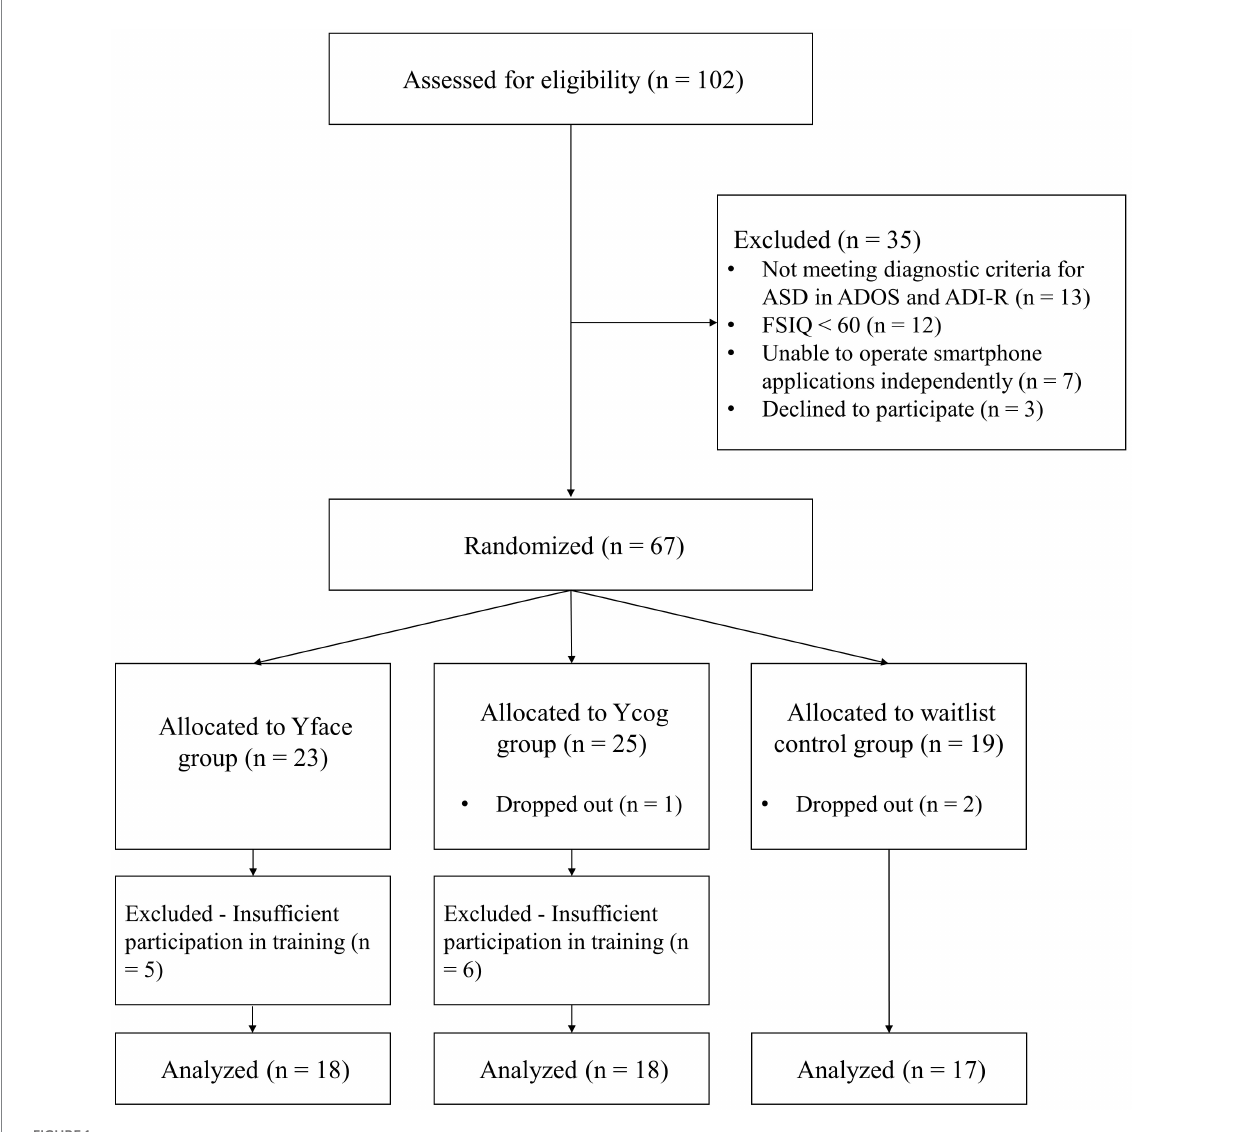
FIGURE 1 Flowchart of the study. ASD, autism spectrum disorder; ADOS, autism diagnostic observation schedule; ADI-R, autism diagnostic interview-revised; FSIQ, full-scale IQ.